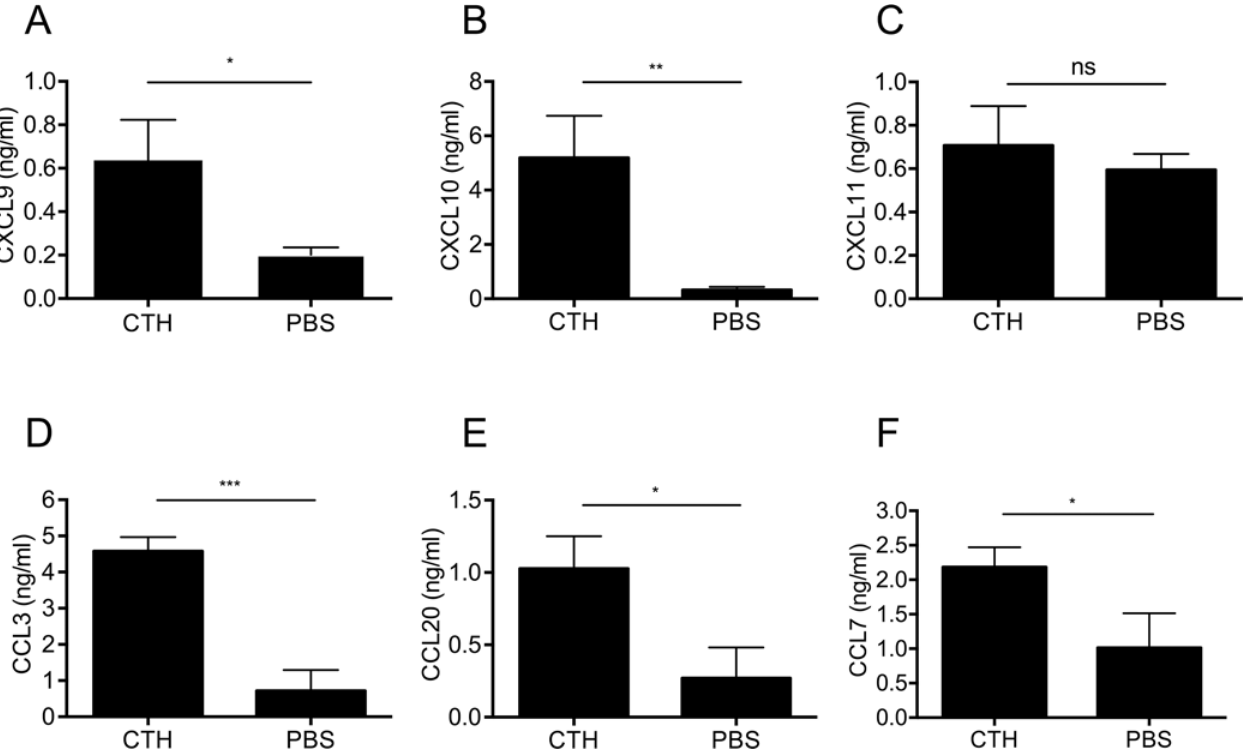
Fig 2. Determination of cytokine levels by ELISA. Human heparinized blood from different healthy donors was incubated with CTHs (60 μ g/ml) at 37°C. After a 12-hour incubation the content of CXCL9 (n = 7) (A), CXCL10 (n = 9) (B), CXCL11 (n = 6) (C), CCL3 (n = 4) (D), CCL20 (n = 4) (E), and CCL7 (n = 4) (F) was measured by